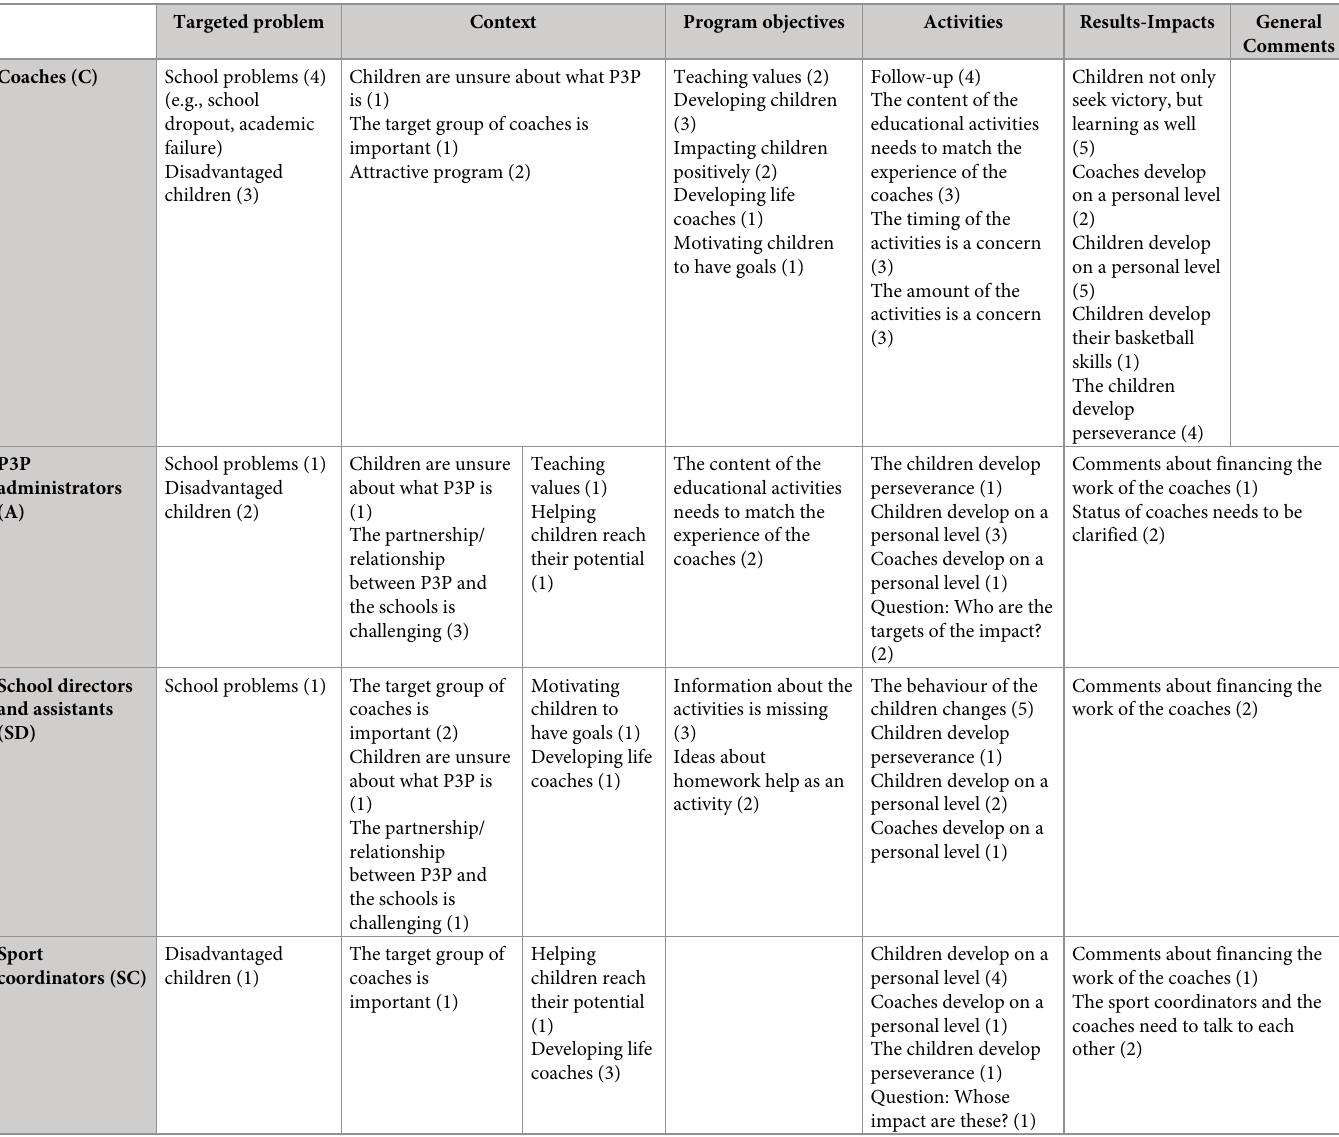
Table 1. Perceptions and patterns of the P3P program regarding the logic model and its